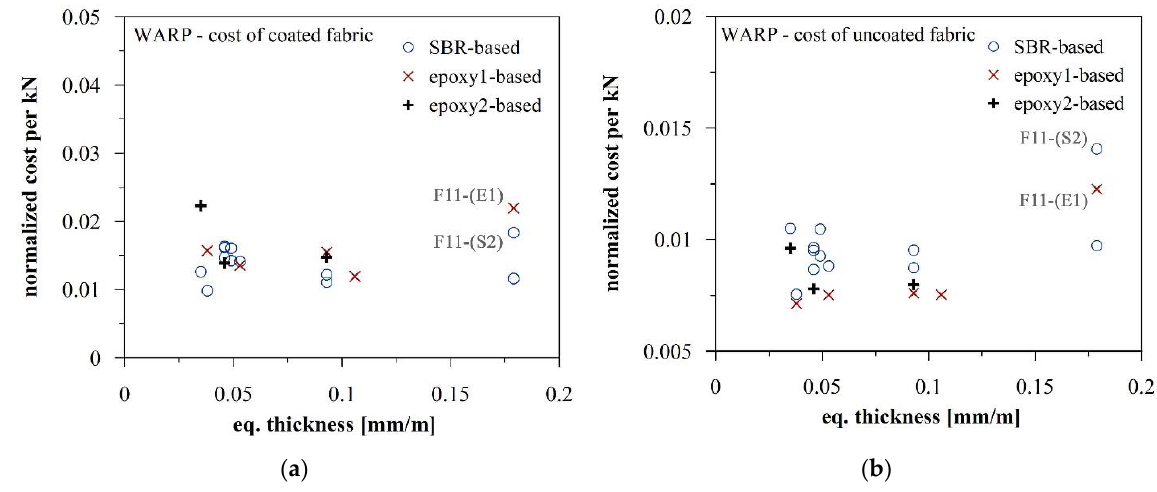
Figure 8. Normalized cost per kN vs. equivalent thickness: cost of the coated ( a ) and of the uncoated fabrics ( b ).